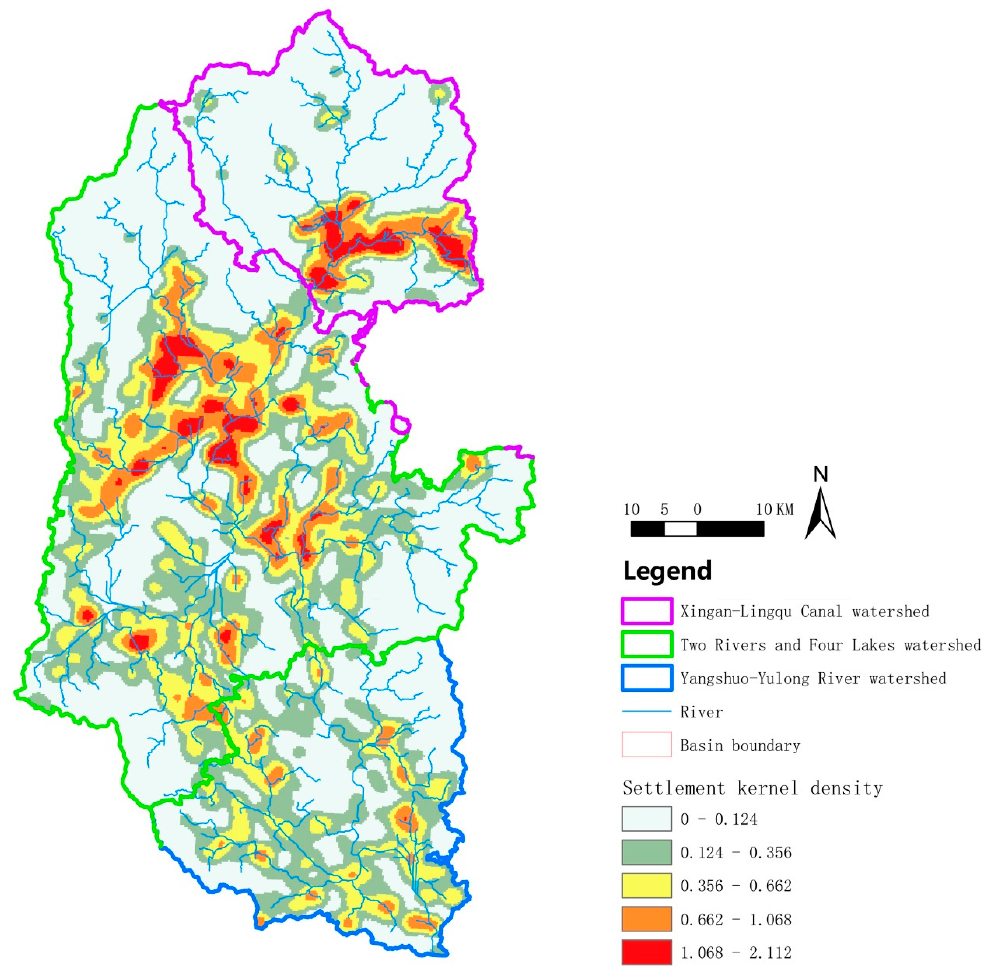
Figure 4. Spatial density distribution plot of rural settlements in the Lijiang River Basin. The redder the patch, the denser the rural